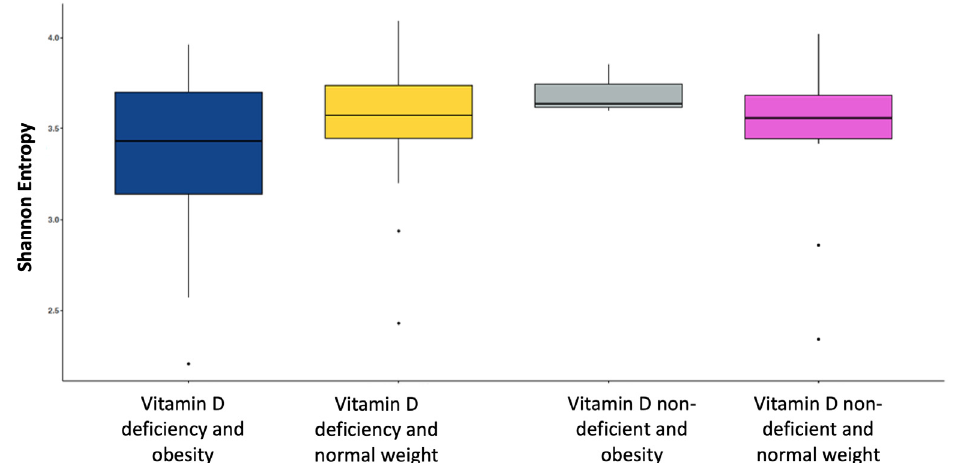
Figure 3. Comparison of bacterial diversity at the species level (Shannon-Wiener index) between participants with obesity and participants with normal weight based on vitamin D level (vitamin D deficiency < 50 nmol/L).